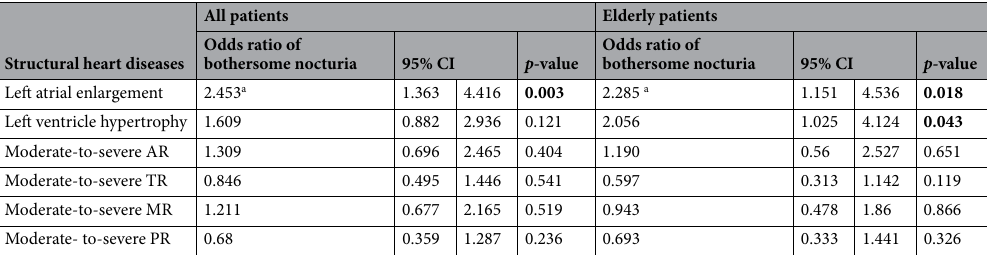
Table 3. Multivariate analysis to investigate the predictive value of bothersome nocturia on various echocardiographic abnormalities in all patients and in the elderly (≥ 65 years) patient groups. AR aortic valve regurgitation; TR tricuspid valve regurgitation; MR mitral valve regurgitation; PR pulmonary valve regurgitation. a Besides adjustment with patients’ age, sex, obesity, hypertension, diabetes mellitus, diuretic use, and, heart disease in other echocardiographic abnormalities, left ventricle hypertrophy was also added to adjust for left atrial enlargement. Significant Values are in